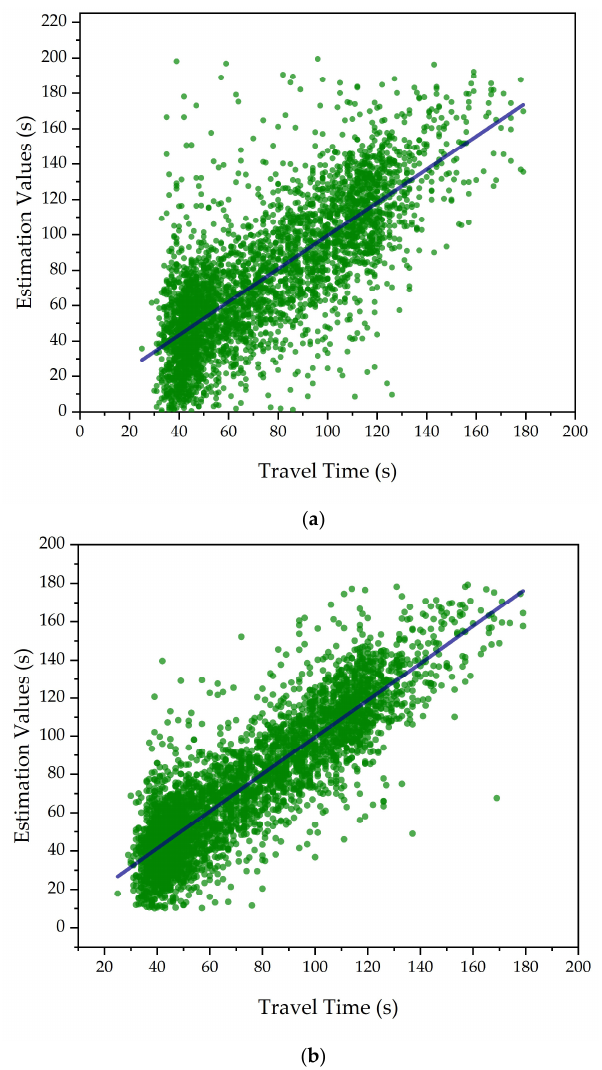
Figure 7. Comparison of the actual values and estimation values of two methods. ( a ) The results of the direct interpolation method. ( b ) The results of the interpolation method based on the DBSCAN results.